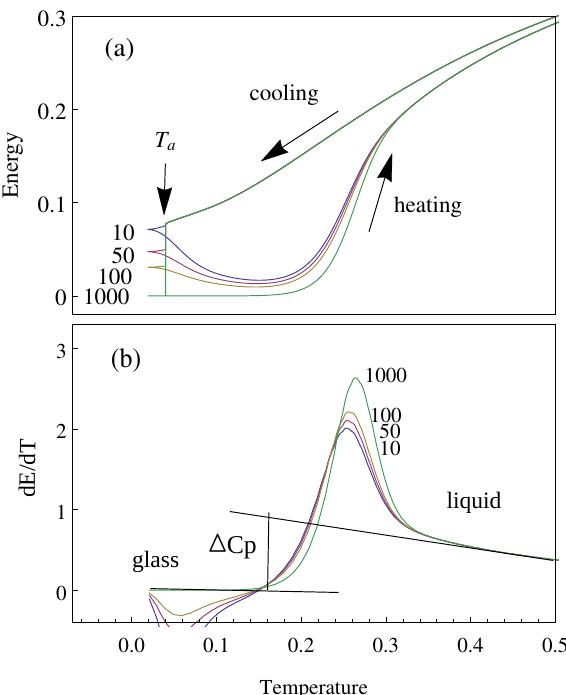
Figure 8. Energy and heat capacity evolution during thermal treatments. ( a ) energy evolution during cooling from equilibrium at q = − 0.01 T units/MS, annealing at T a = 0.04 during 10 to 1000 MS and heating at q = 0.01 T units/MS; ( b ) the temperature derivative of the energy, the heat capacity, on heating after the same isothermal annealing periods. In addition, the heat capacity step ∆ C p found between the liquid and glass states is